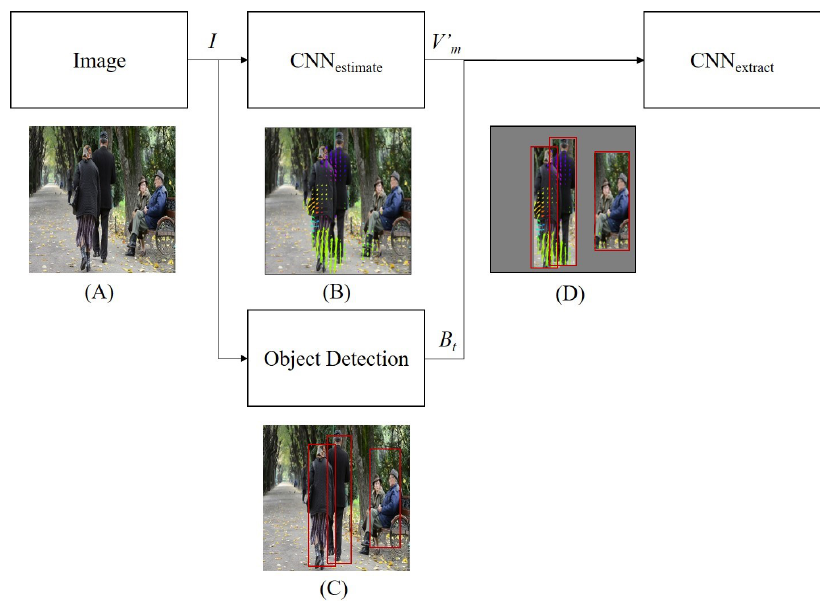
Figure 3. Overall architecture of motion-convolutional neural networks (CNN) and examples cor- responding to input image: ( A ) input image example and ( B ) depiction of estimated optical flow. Following Gao et al. [11], we use same-color coding to visualize flow for best viewed: ( C ) depiction of estimated object detection and ( D ) flow with only the object area